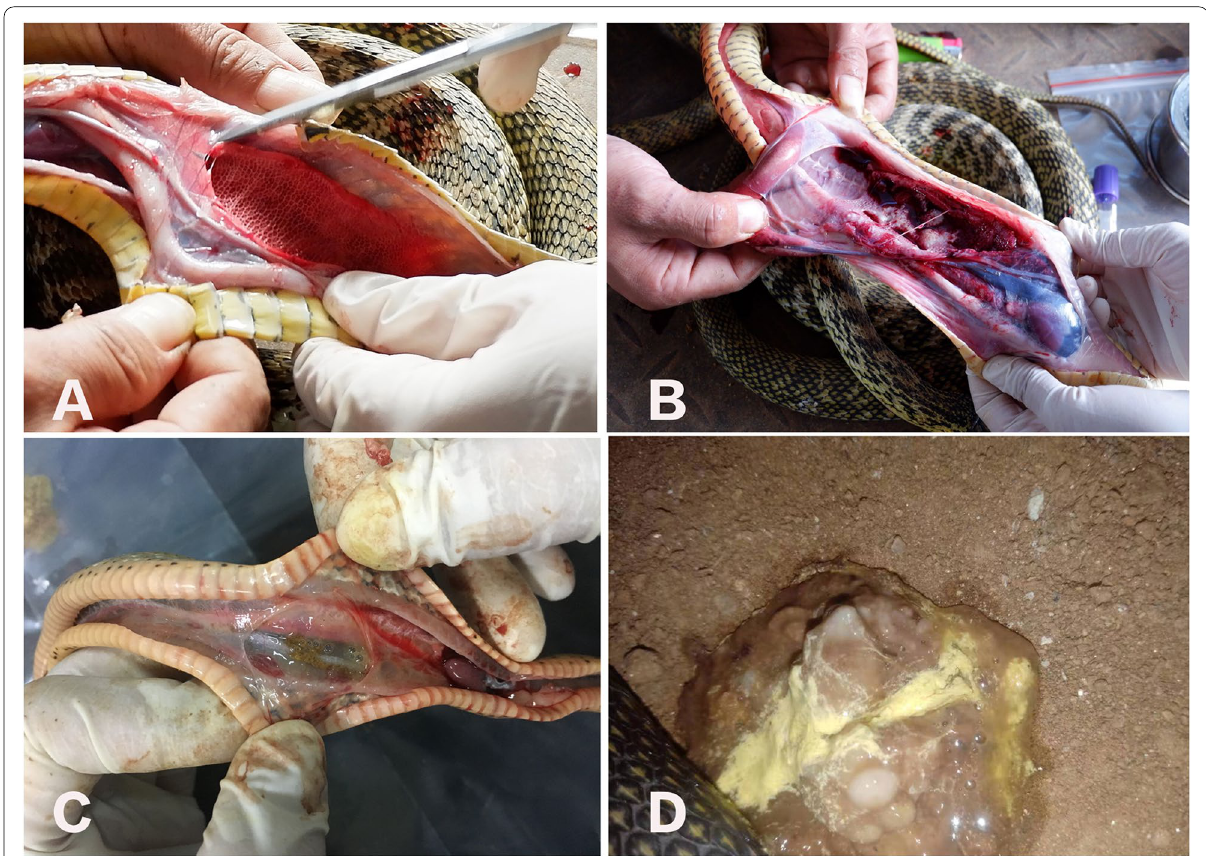
Fig. 2 Field dissections. A Normal pink reticular lung tissue in Elaphe carinata ; B Purulent mucous secretion seen in damaged lung tissue in infected Elaphe carinata ; C Greenish exudate seen in between damaged lung tissue in infected Ptyas mucosus ; D Watery diarrhea seen in Elaphe carinata